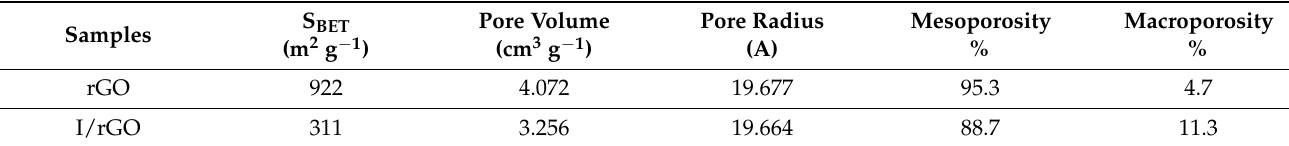
Figure 4. BET isotherms and BJH curves corresponding to iodine − doped graphene. Table 3. Comparative textural properties of rGO and iodine − doped graphene.